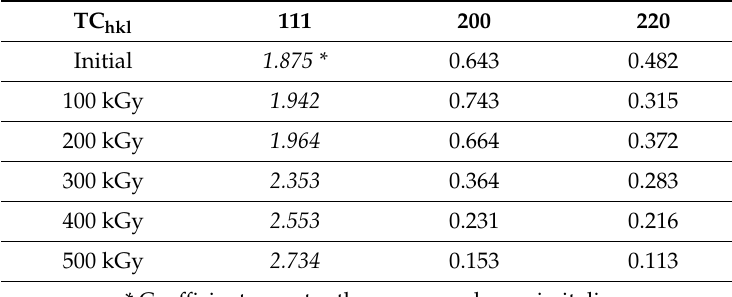
Table 2. Texture coe ffi cient